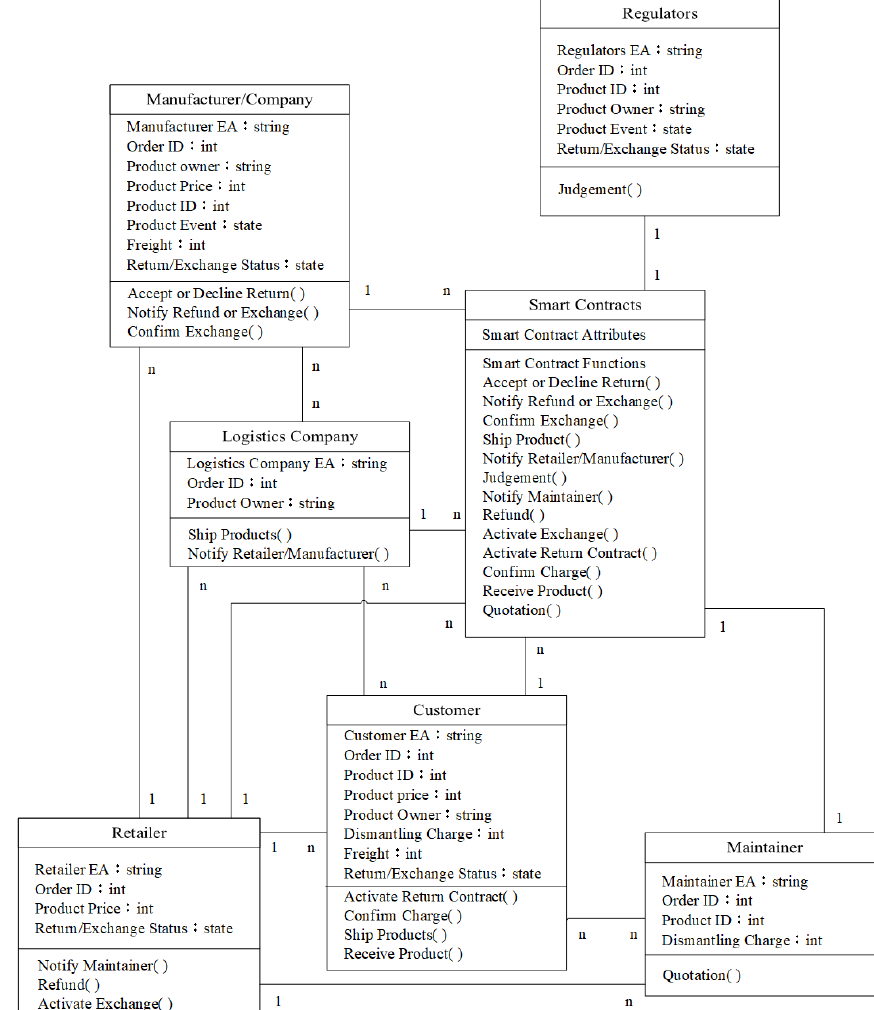
Figure 7. Entity-relationship diagram.